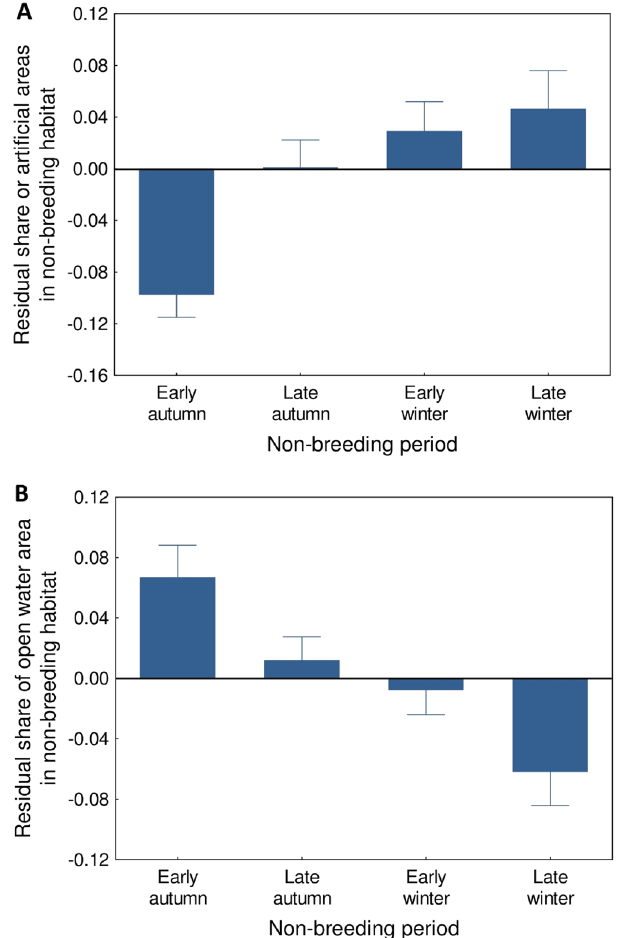
Figure 3. The share of artificial ( A ) and open water ( B ) areas in habitats (0.5 km scale) selected by Eurasian coots in different periods of non-breeding season. Residuals from general linear mixed models (means ± SE) are